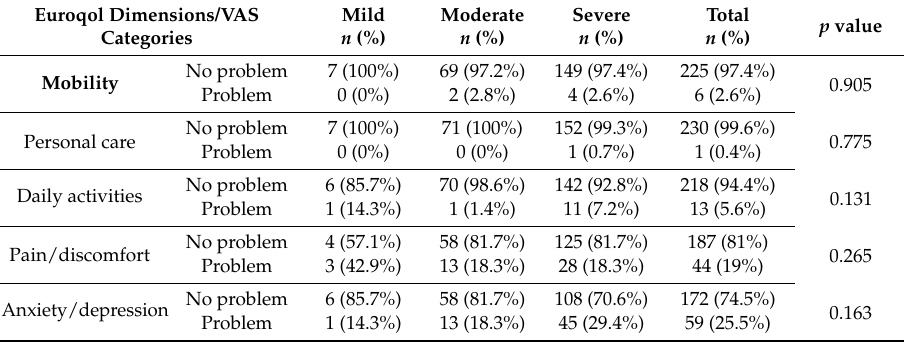
Table 4. Dimensions of Euroqol identified as problems in women grouped according to the intensity of their